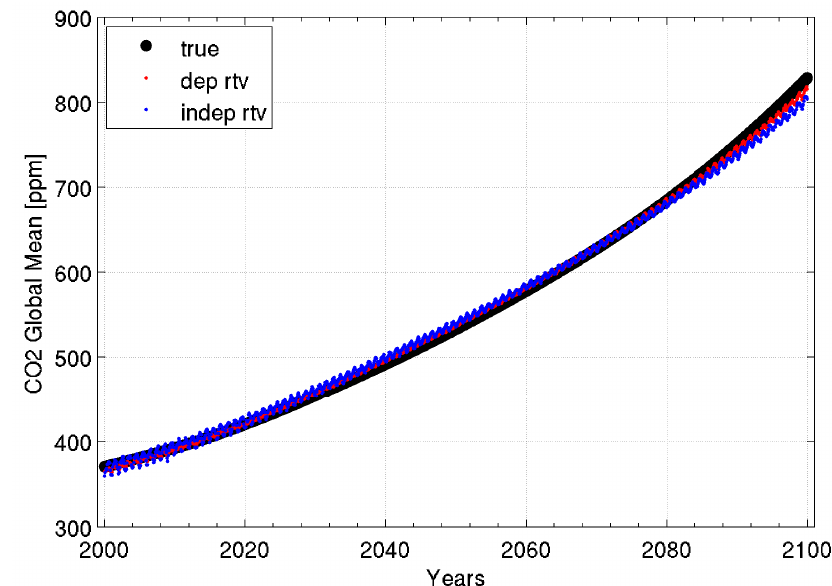
Figure 1. Comparison between the model global and monthly mean CO 2 concentration (black dots) with two types of global and monthly mean CO 2 concentration retrievals, derived from a dependent (red dots) and independent (blue dots) regression training set.